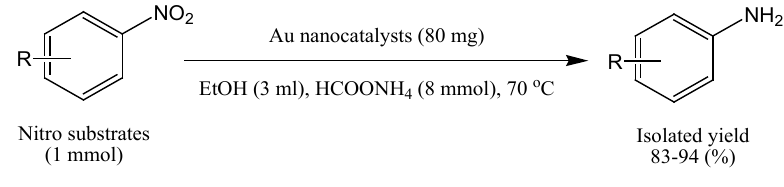
Figure 1. Hydrogenation of nitrobenzene